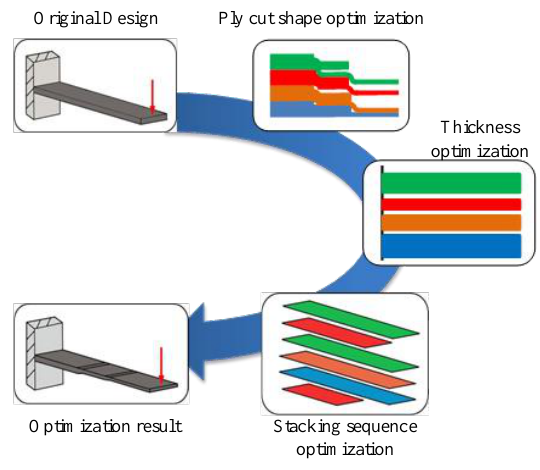
Figure 3. Steps of segmented optimization.